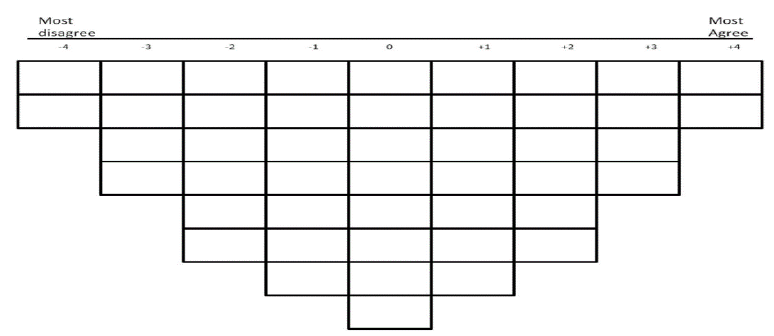
Figure 1. A summary of the process of conducting a Q study [23].